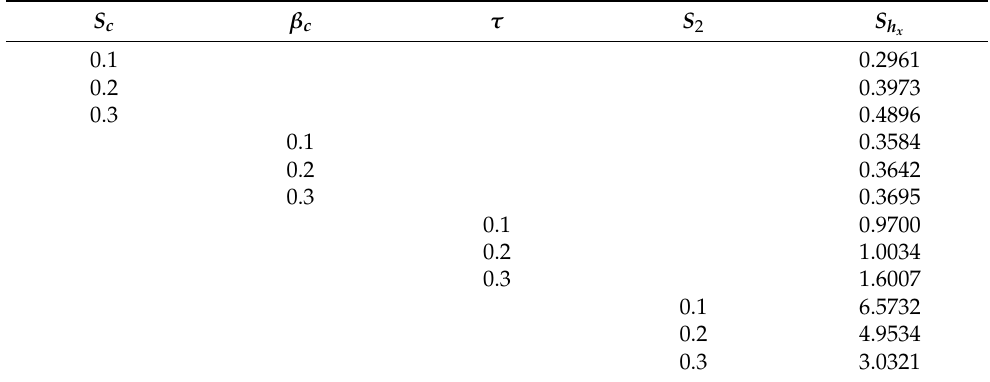
Table 3. Numerical variations of Sherwood number against some parameters at S 1 = 0.1, E c = 0.3, θ w = 0.2 and τ = E c 2